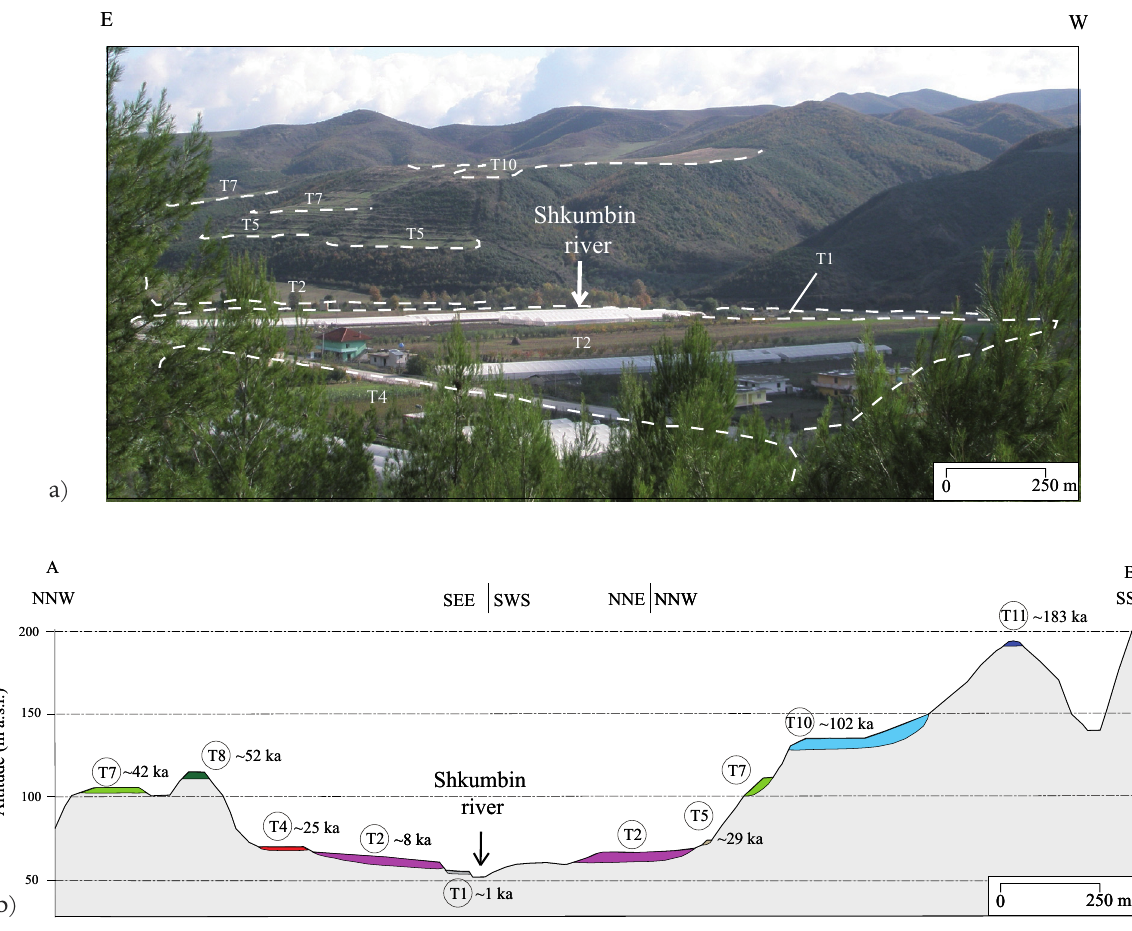
Figure 8. (a) Panoramic view of the lower Paleo-Devoll river showing the location of terraces. The numbers refer to the nomenclature pro- posed in Guzmán [2013]. The present Shkumbin river is shown in the figure. (b) Cross section through the encased terraces in the lower Paleo- Devoll. The ages of the terraces from previous studies are indicated [Lewin et al. 1991, Hamlin et al. 2000, Woodward et al. 2001, Koçi 2007, Carcaillet et al. 2009, Guzmán